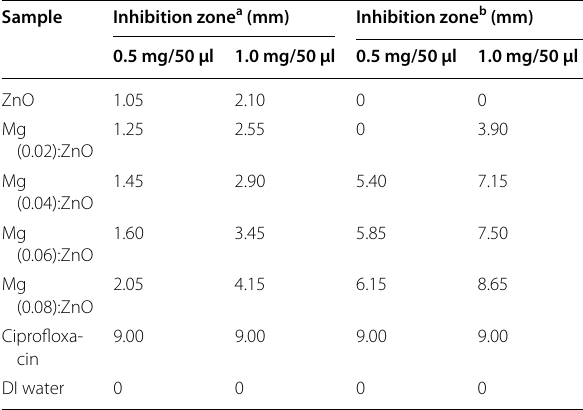
a Inhibition zone diameters (mm) for S. aureus b Values of zones of inhibition for E. coli